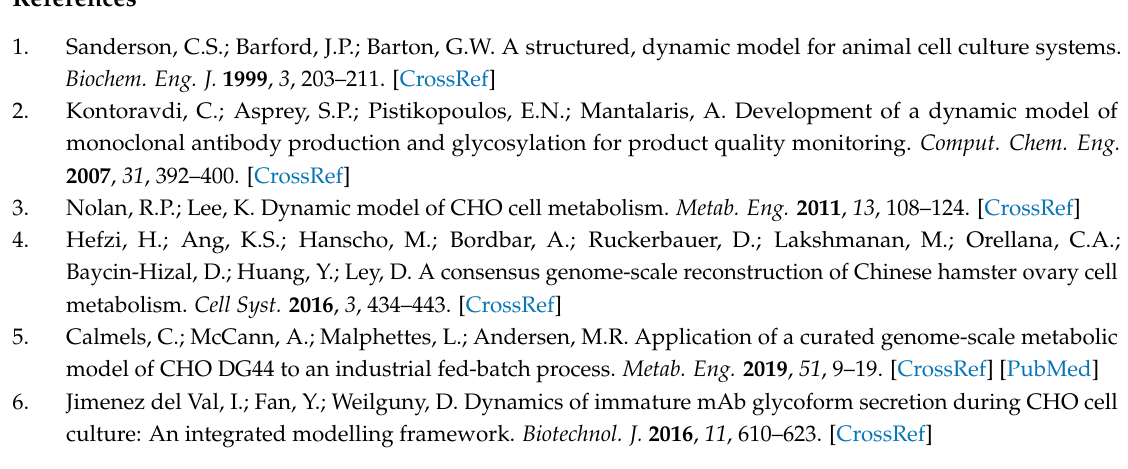
Figure S1: Correlations between the outputs (metabolites/amino acids) and the inputs (model parameters) for sensitivity index threshold set at (A) 0.05, (B) 0.1 and (C) 0.2, Table S1: Nomenclature of parameters used in the mathematical